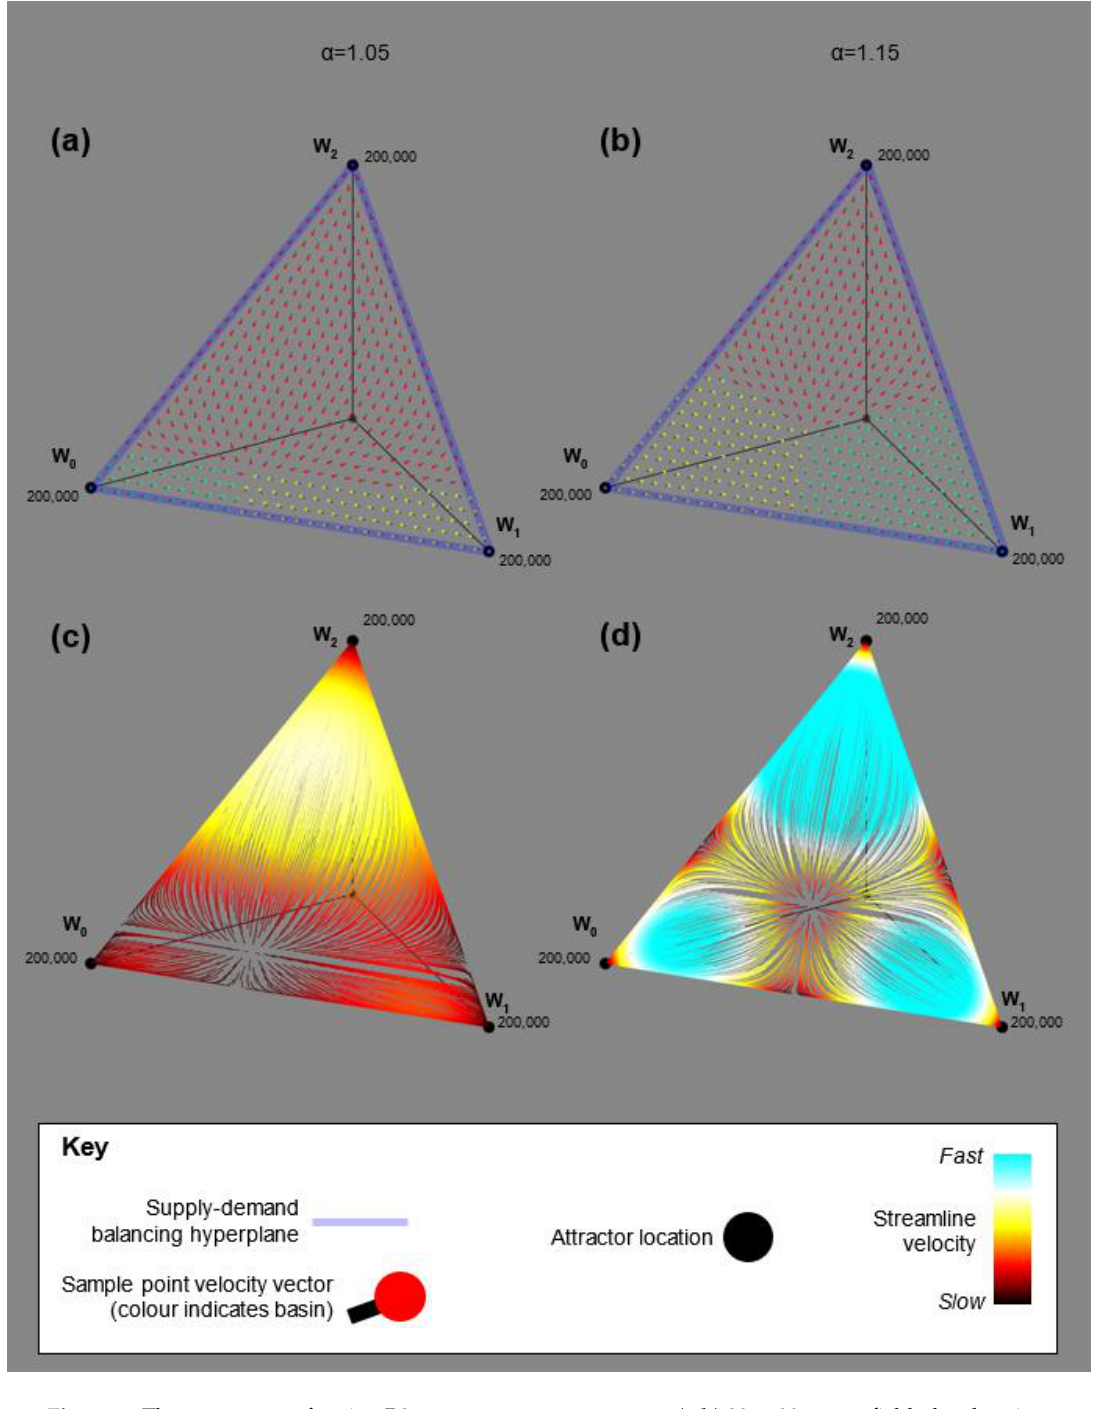
Figure 3. The state space of region R2 across two parameter sets: ( a , b ) 30 × 30 vector field plot showing three basins; and ( c , d ) 50 × 50 streamlines with velocity colour-coded. Note: b = 0.05.